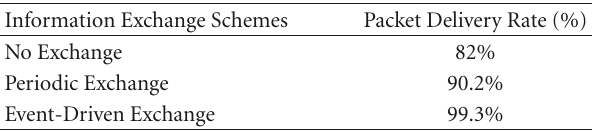
Table 3: Packet Delivery Rate (%) for Periodic and Event Driven Message